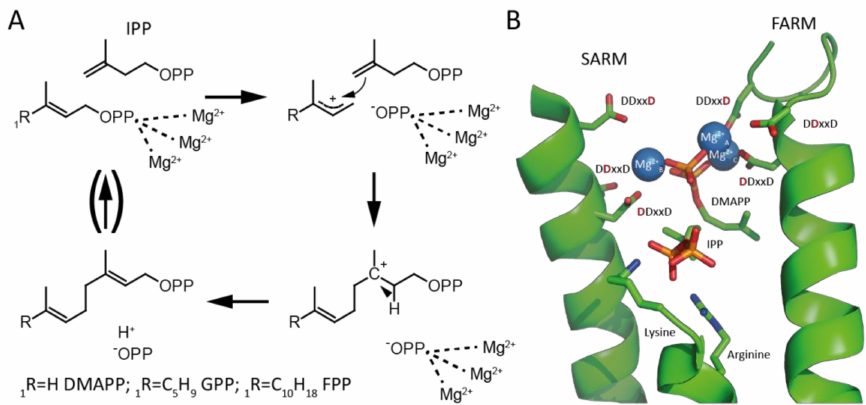
Figure 1. Trans -isoprenyl diphosphate synthase (IDS) reaction mechanism and coordination of substrate diphosphate moieties in the active site of trans -IDS. ( A ) The allylic substrate is coordinated by three Mg 2+ co-factors that assist initiating ionization of the diphosphate ester. The resulting carbocation is attacked by the double bond of isopentenyl diphosphate (IPP), leading to formation of a bond between the allylic substrate and IPP and a shift of the carbocation. The resulting carbocation is quenched by deprotonation and formation of a new trans /( E )- double bond in the elongated product. This product can act as the allylic substrate for further elongation with another IPP molecule. ( B ) The active site of the ( E,E )-farnesyl diphosphate synthase from E. coli complexed with its substrates IPP and dimethylallyl diphosphate (DMAPP) (Protein Data Bank (PDB) ID code: 1RIQ). The diphosphate moiety of the allylic DMAPP is activated by coordination to three Mg 2+ that are, in turn, bound by the characteristic first and second aspartate-rich DDxxD motifs (FARM and SARM), as shown. More specifically, Mg 2+ A and Mg 2+ C are coordinated by the first and last aspartate of the FARM, while Mg 2+ B is largely coordinated by the first aspartate of the SARM. By contrast, the diphosphate moiety of IPP is more directly bound by the basic residues shown. Note that, while the structure contains the thiolo analog of DMAPP, for illustrative purposes the color of the sulfur was changed to red to resemble that of the oxygen found in